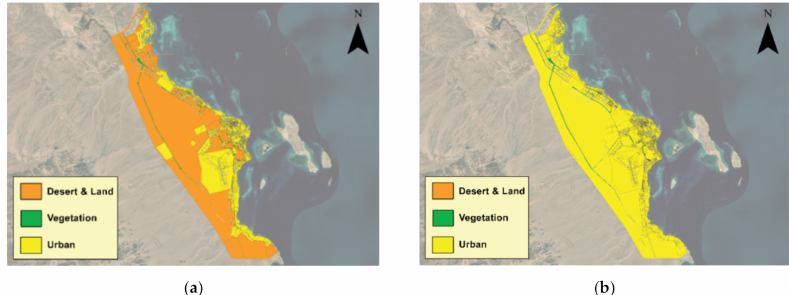
Figure 4. Current land cover ( a ) and future land cover ( b ) (2027) of